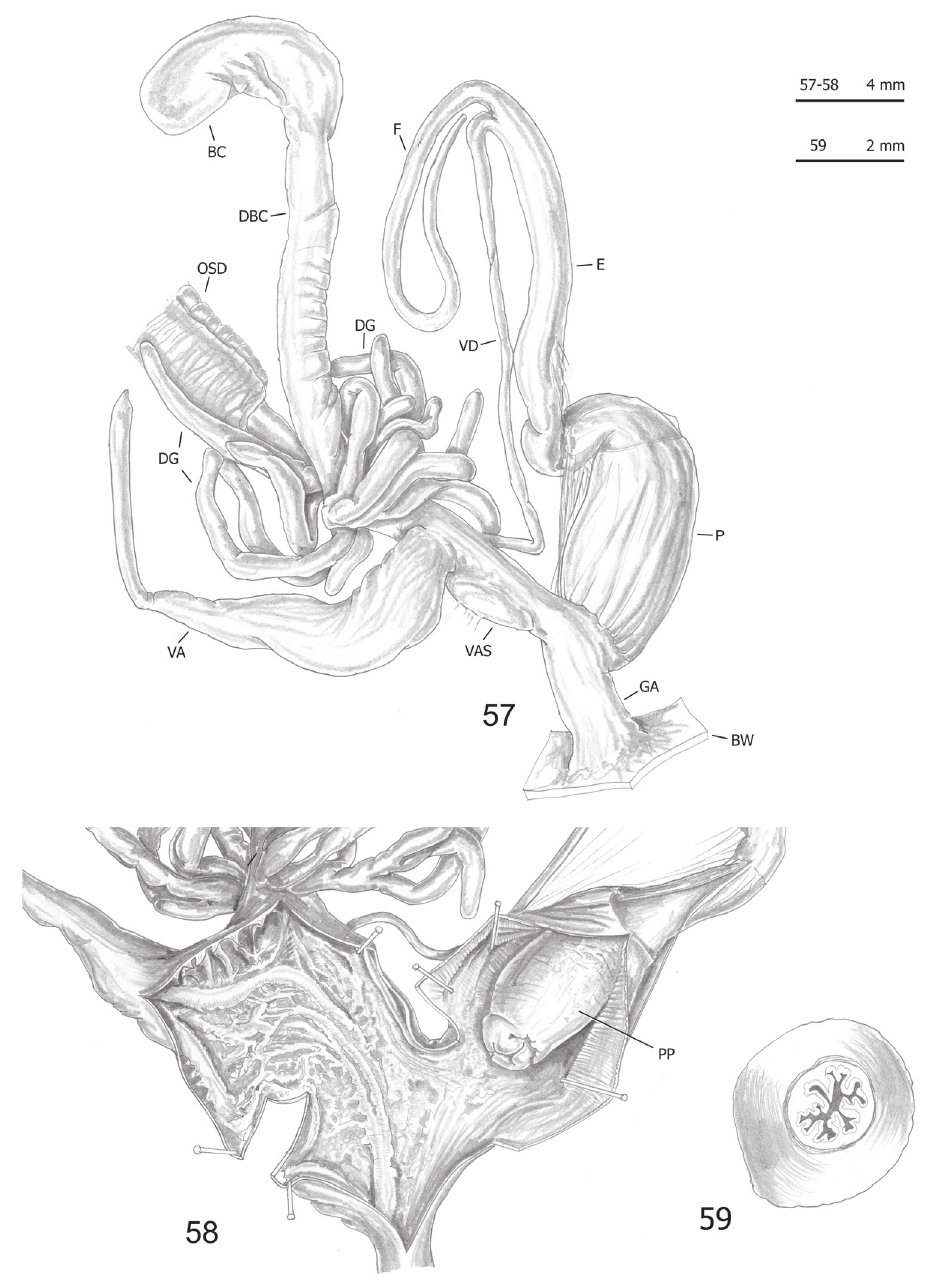
and transverse section of apical penial papilla ( 59 ) of Monacha pantanellii from Lago del Turano [Tur2] (FGC